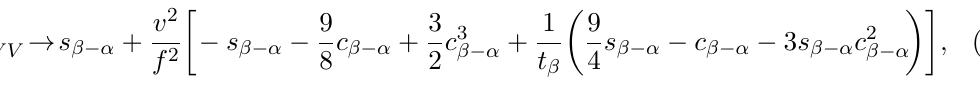
Figure 2 . (a) Dashed and solid contours represent σ ( gg tree-level and BP1 of 2HDMEFT respectively, (b) contours of Br ( h tree-level 2HDM and BP1 which almost overlap with each